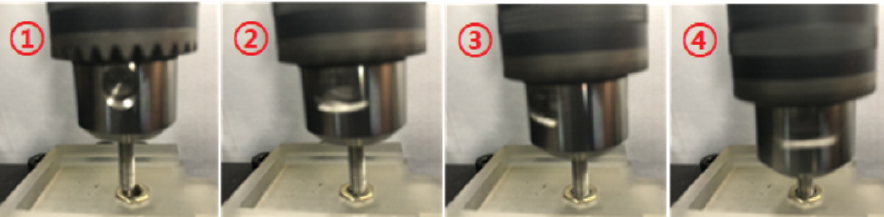
Figure 7. Utilizing the buffer, the ID can move through a slightly misaligned TH. The movement order is 1 (cid:13) → 2 (cid:13) → 3 (cid:13) → 4 (cid:13) .